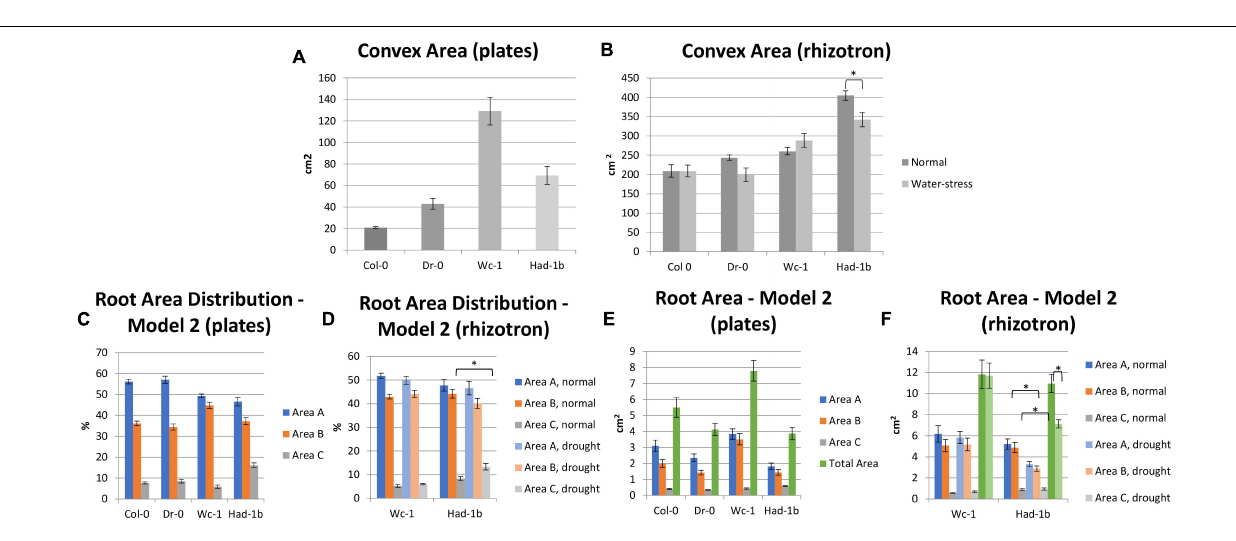
FIGURE 7 | (A–F) Comparison between the results of RSA trait measurements in plates ( in vitro ) and in rhizosheets. *, p < 0.05 as analyzed by a Student’s t